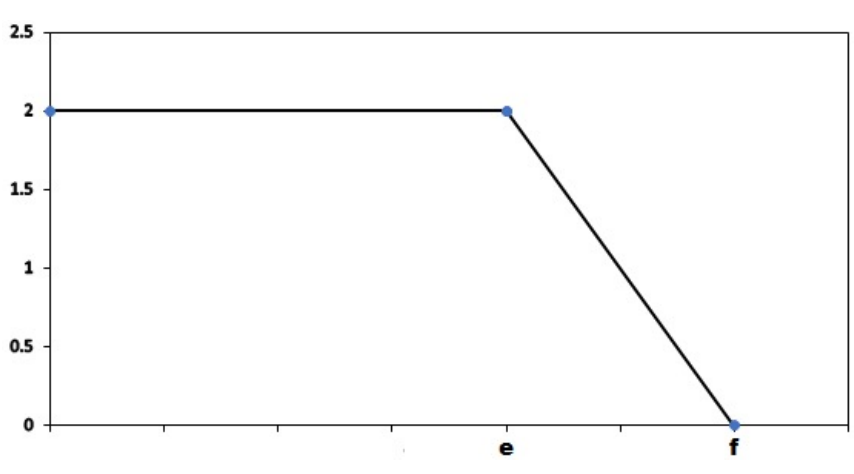
Figure 9. R–Trapezoidal